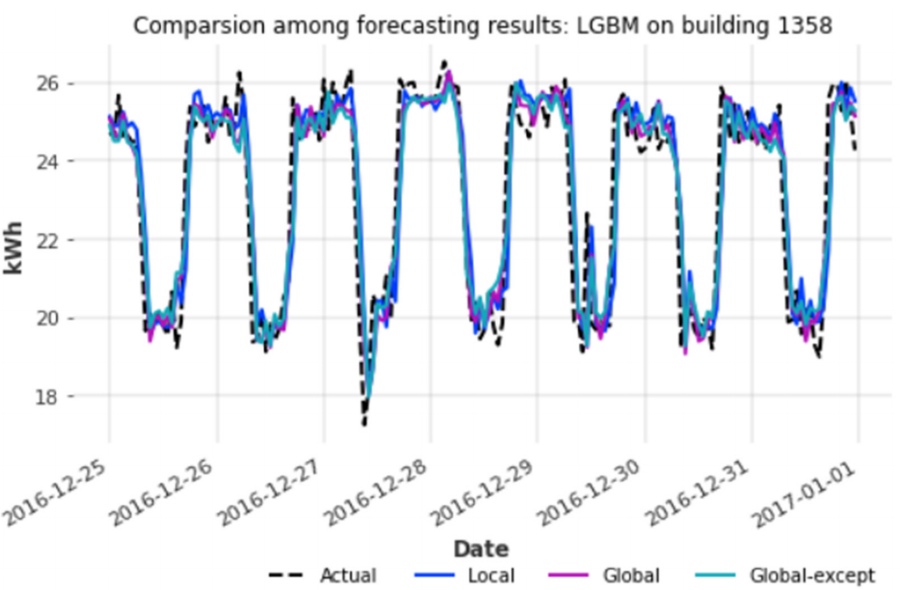
Figure 17. Comparison between the forecasting results using LGBM model for building 1358. Actual: ground-truth; Local: local model trained using training set of building 1358; Global: global model trained using training set of all buildings; Global-except: global model trained using training set of all the buildings excluding building